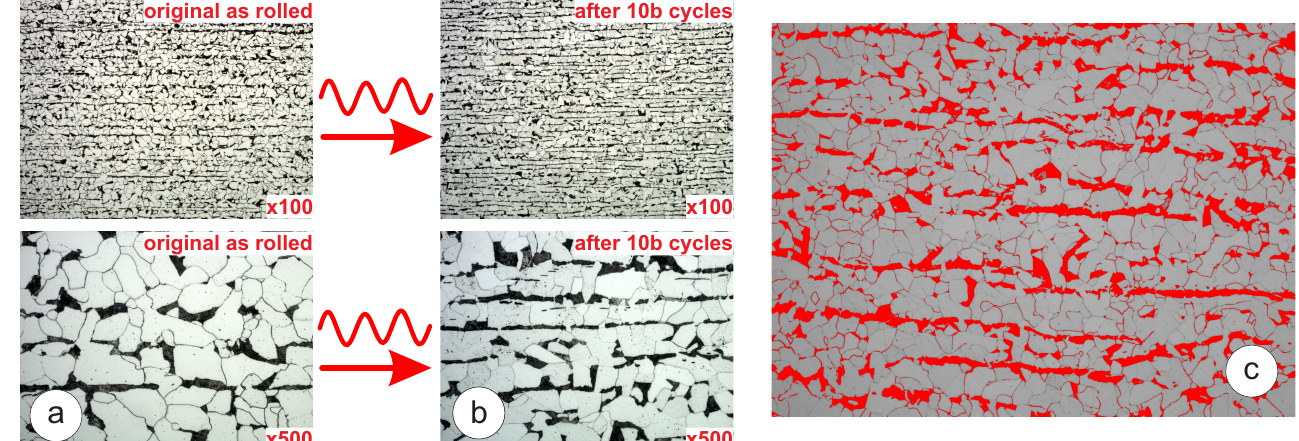
Figure 9. Microstructure of S275JR+AR steel extracted from the sample at the fatigue limit σ lim = 340 MPa: ( a ) before testing; ( b ) after 10 billion cycles; ( c ) processed micrograph showing the pearlite (red) and ferrite (white)